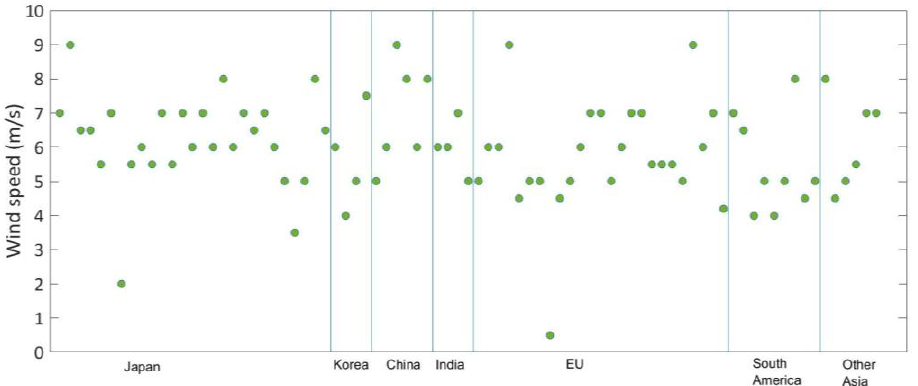
Figure 16. Maximum wind speeds around the world.